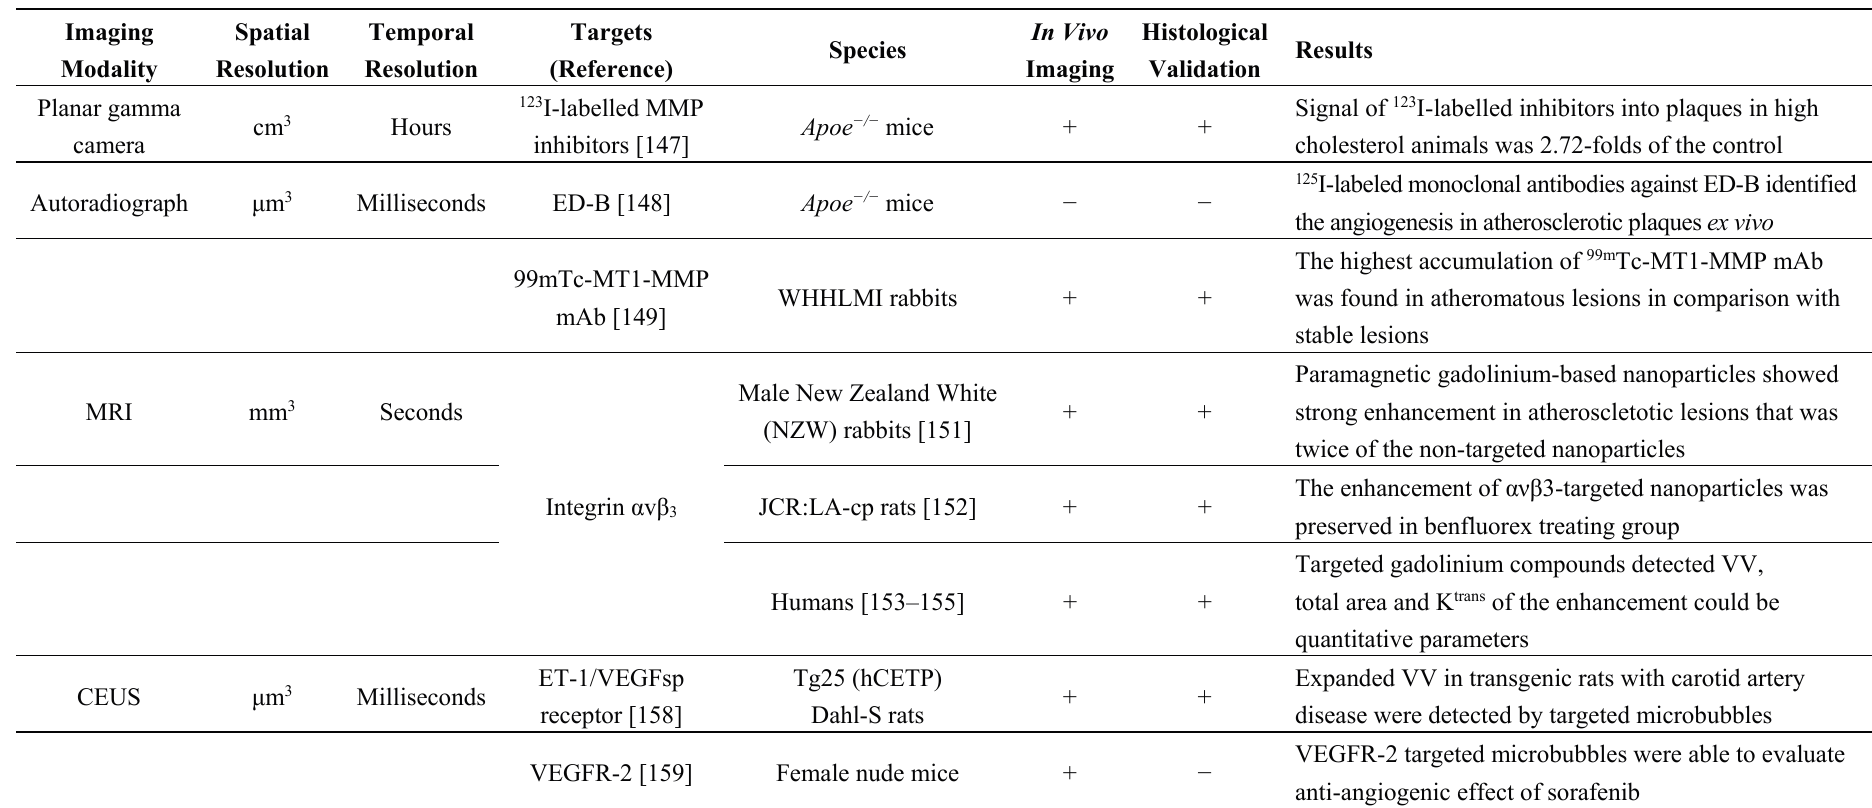
Table 1. Molecular imaging modalities and targets of vasa vasorum in atherosclerosis